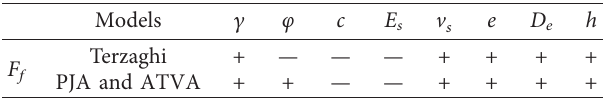
Table 5: The relationship between the parameters and the calcu- lated friction.